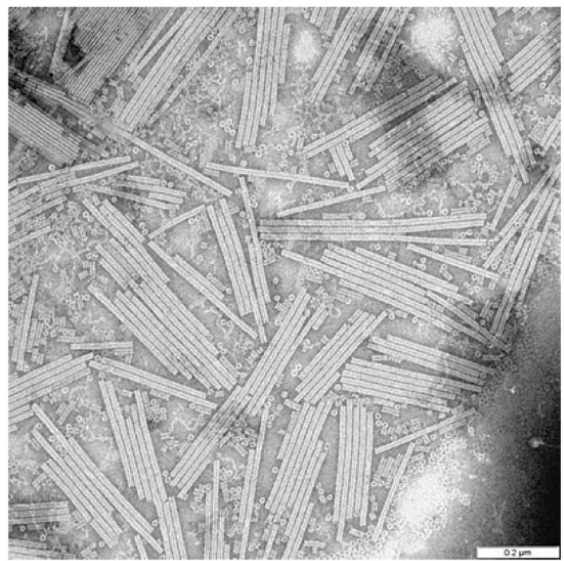
Figure 7. Cholesteric mesophase observed under electron microscopy. Reproduced from [80].